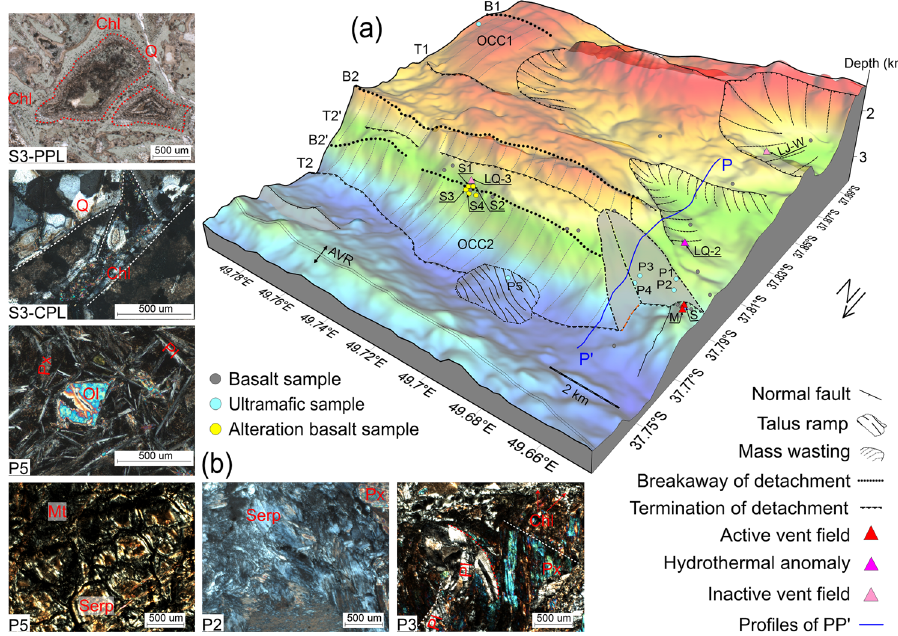
Fig. 4 Interpretation of microphysiography of the Dragon Horn OCC2 system. a The basic geologic and morphologic structure. detachment fault breakaways (B1, B2, B2 ′ ) are shown by black dotted lines and terminations (T1, T2, T2 ′ ) are shown by black hachured dashed lines. Thinner black hachured lines show areas of mass wasting and trajectories of collapse. Gray shaded areas shows the extent of the OCC2 fault surface near LQ-1. Lined area is a region of talus accumulated at the base of the OCC2 scarp. Triangle symbols are hydrothermal vent locations as described in the legend. Dots are sample locations with lithologies as described in Fig. 1 caption. Blue line is Pro fi le PP ′ modeled in Fig. 5. b Photomicrograph and major minerals of representative rock samples which are observed in cross-polarized light (CPL), except the fi rst (S3) with plane-polarized light (PPL). Sample S3, altered basalt fi lled with chlorite and a small amount of quartz (Q) in the ring banded structure and basalt detritus. Sample P5, peridotite is strongly altered and has formed serpentine and magnetite (Mt). Sample P2 has a network structure and mainly contains serpentine (Serp), residual peridotite, and pyroxenes (Px). Sample P3, bends and fractures are found and plagioclase (Pl), chlorite (Chl), and pyroxenes are present. Where the white dotted line is a fracture, red dotted curve line is a bend, and red enclosed line is a ring banded structure.